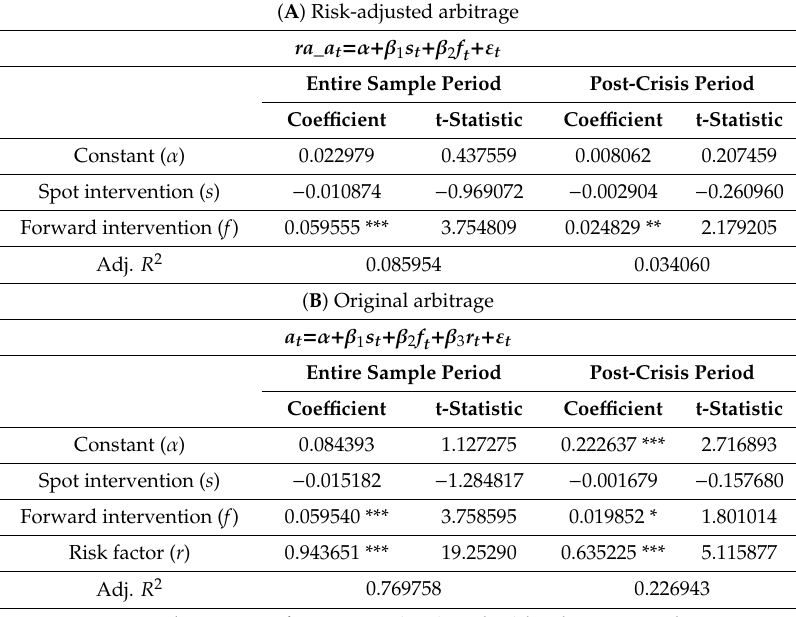
Table 10. Estimation results for the determination of arbitrage